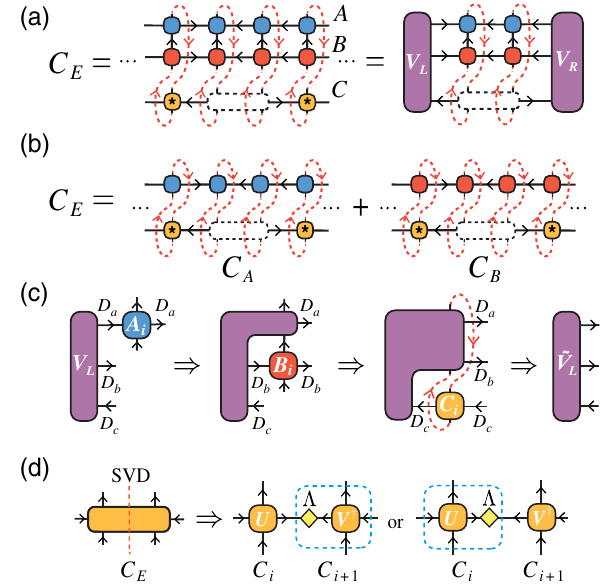
FIG. 17. (a) The environment tensor C E in two-site variational optimization of compressing the product of two MPOs into a single MPO, i.e., C ≔ A (cid:3) B [cf. Eq. (D2)]. Arrows on the horizontal lines demonstrate orthonormalization or, equivalently, canonicalization of the MPO. The environment C E can be evaluated by contracting the cluster which consists of two environment tensors V L and V R , as well as relevant MPO tensors. (b) The environment tensor C E in two-site variational scheme of rewriting the sum of two MPOs into a single MPO, i.e., C ≔ A þ B [cf. Eq. (D4)]. An asterisk inside a box indicates a “ daggered ” tensor. (c) Update the left environment tensor V L with three local tensor A i , B i , and C i of MPOs A , B , and C , respectively. The computational costs of the three substeps (from left to right) are O ð D 2 a D b D c Þ , O ð D a D 2 b D c Þ , and O ð D a D b D 2 c Þ , respectively. V R can be updated in a similar way. (d) Update of the local tensor T (cid:3) i and T (cid:3) i of MPO C , by performing SVD on þ 1 either environment tensor C E or ð C A þ C B Þ